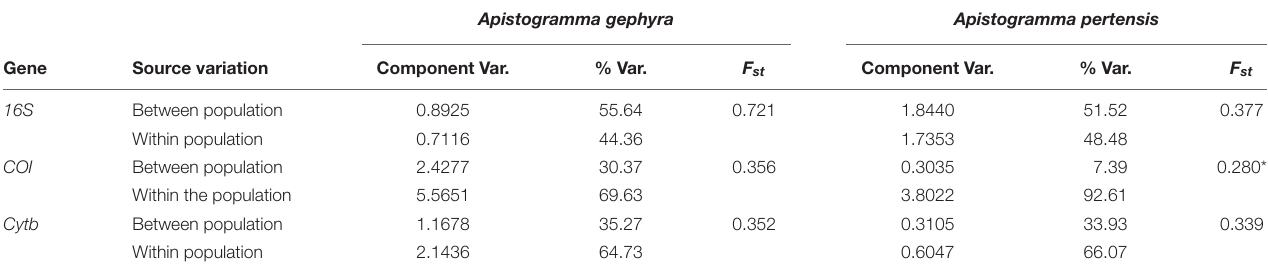
TABLE 5 | Analysis of molecular variance (AMOVA) of Apistogramma gephyra and Apistogramma pertensis based on mtDNA genes. Apistogramma